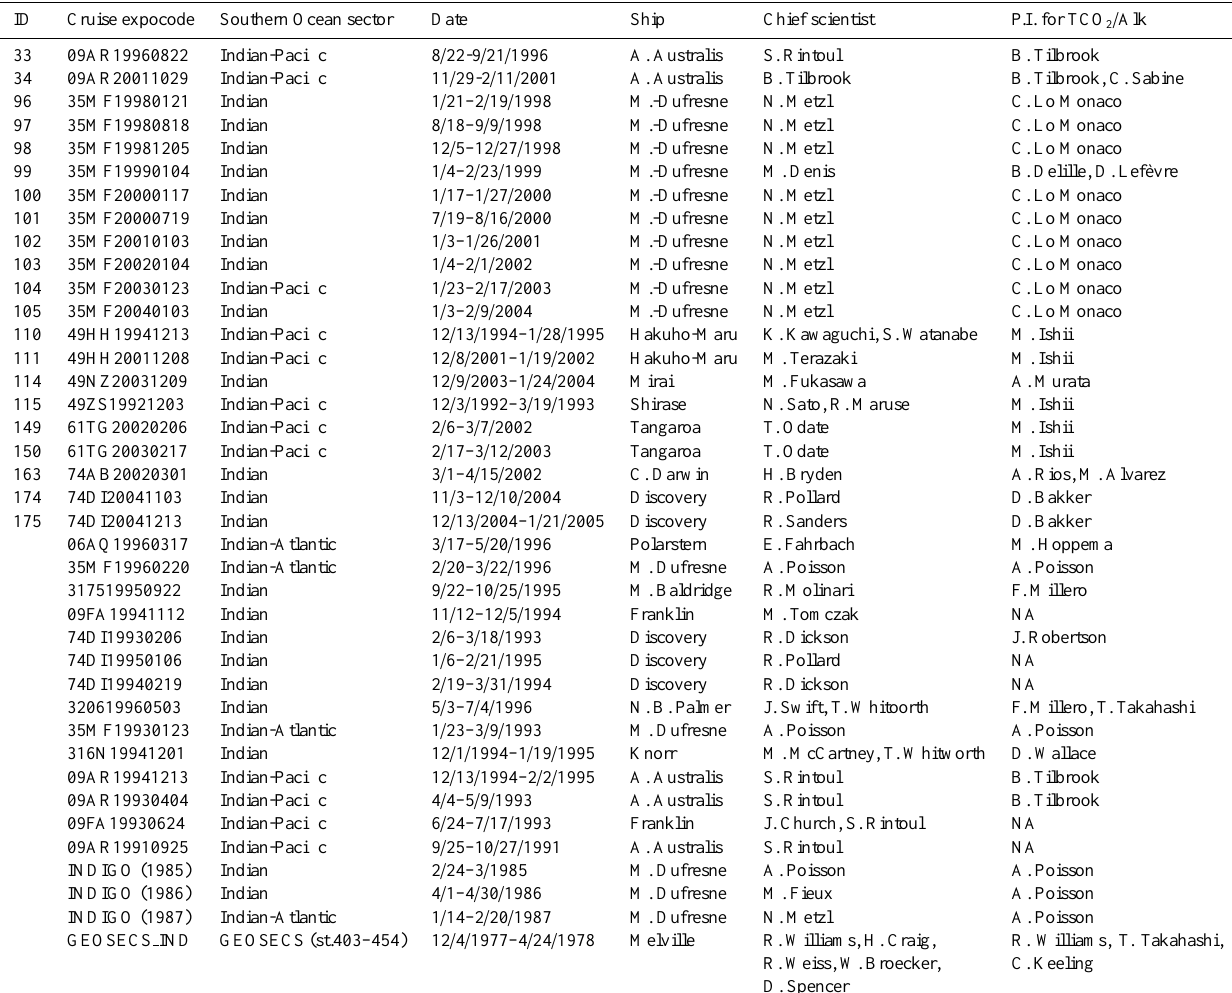
Table 1. CARINA and GLODAP cruises assembled in the Southern Indian dataset. CARINA cruises are identified by their cruise number